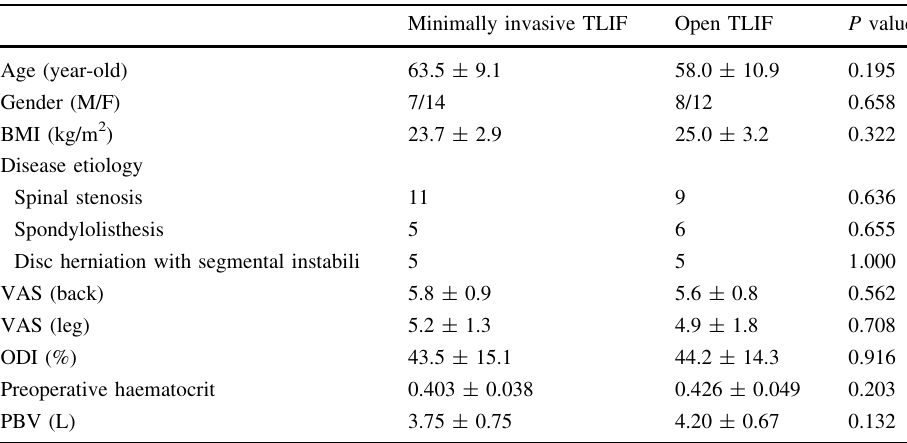
Table 2 Comparison of perioperative volume loss of RBC between minimally invasive and open group